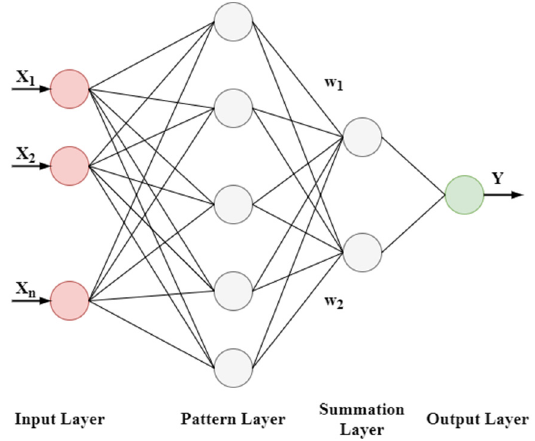
Figure 1. General structure of GRNN based on description contained in [52,53].